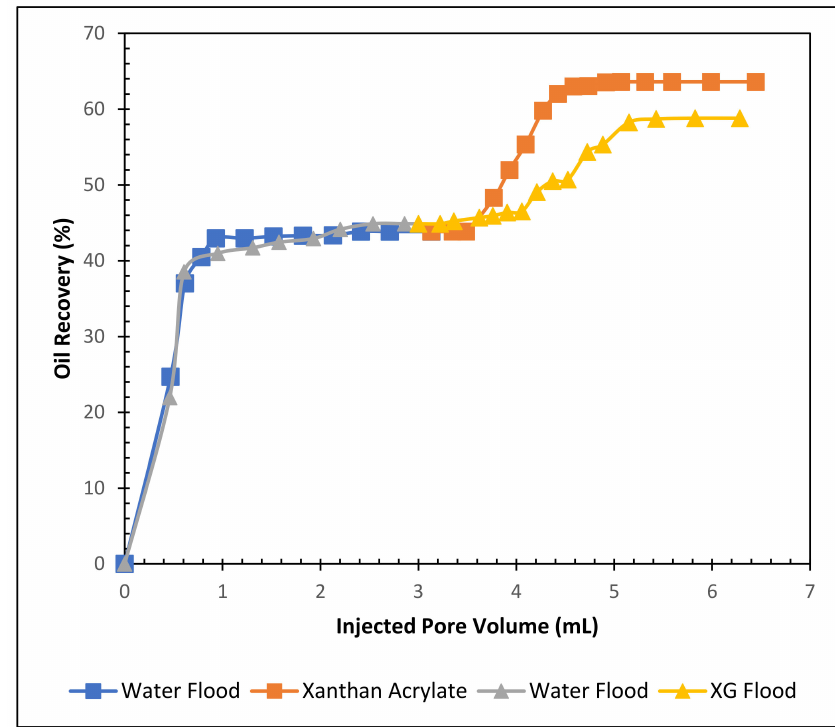
Figure 6. Total oil recovery observed from the two